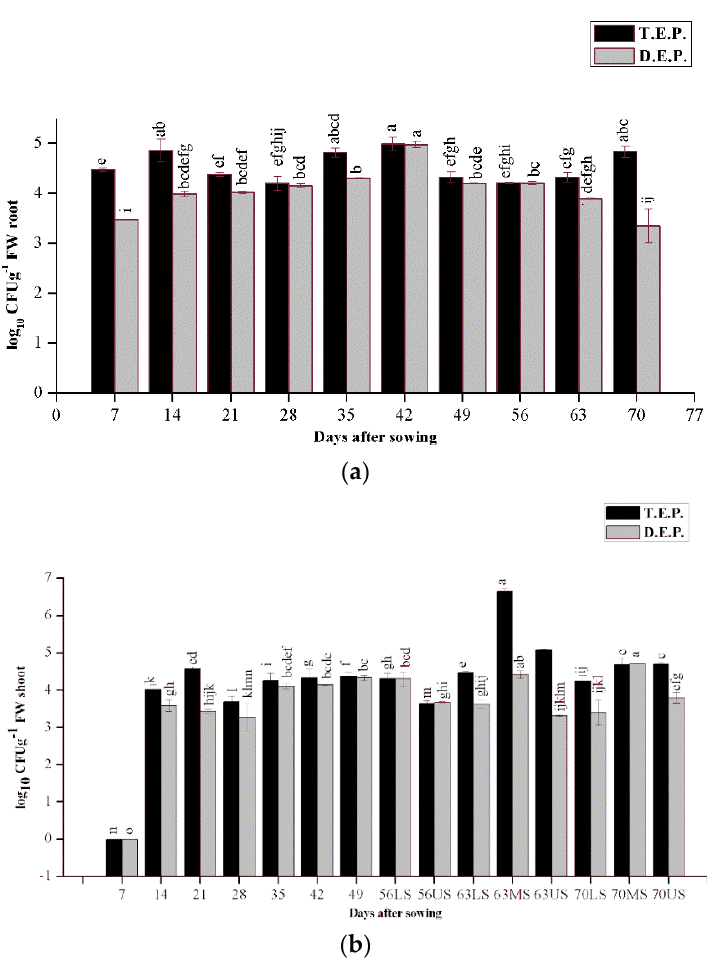
Figure 1. Comparison of total endophytic (TEP) and diazotrophic endophytic population (DEP) with the growth of Pennisetum glaucum in ( a ) Root and ( b ) Shoot. Letters L, M, U denote lower, middle and upper parts of stem. Vertical bars represent standard deviation. The mean values were compared, using Duncan’s multiple range test (DMRT) at p < 0.05. Values that were significantly different from each other are headed by different letters in different samples (Data obtained from Gupta et al., 2013